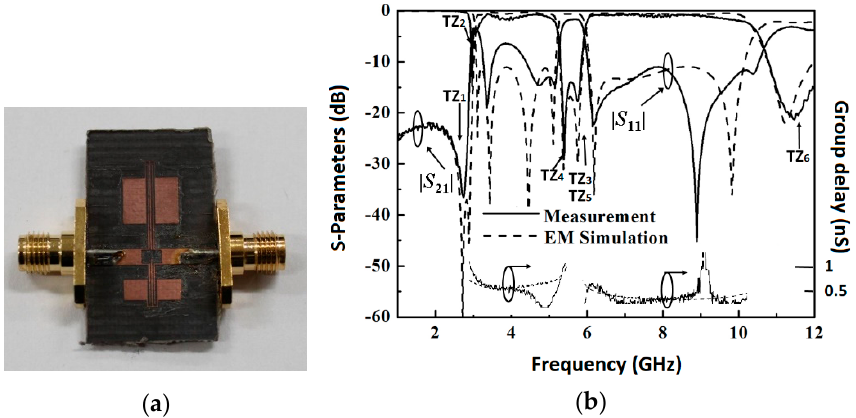
Figure 8. ( a ) Photograph and ( b ) simulated and measured results of the UWB BPF and group delay of the first UWB response from 3.1 to 5 GHz and second UWB response from 6 to 10.1 GHz. For the first UWB BPF, L 1 = 3.35 mm, L 2 = 7.1 mm, L s = 13.7 mm, W 1 = 3.38mm, W 2 = 0.2 mm, W s = 0.2 mm, G 1 = 0.2 mm, G 2 = 0.15 mm, G 3 = 0.15 mm. For the second UWB BPF, L 1 ’ = 1.85 mm, L 2 ’ = 3.1 mm, L s ’ = 6.95 mm, W 1 ’ = 3.43 mm, W 2 ’ = 0.2 mm, W s ’ = 0.2 mm, G 1 ’ = 0.2 mm, G 2 ’ = 0.15 mm, G 3 ’ = 0.15 mm.